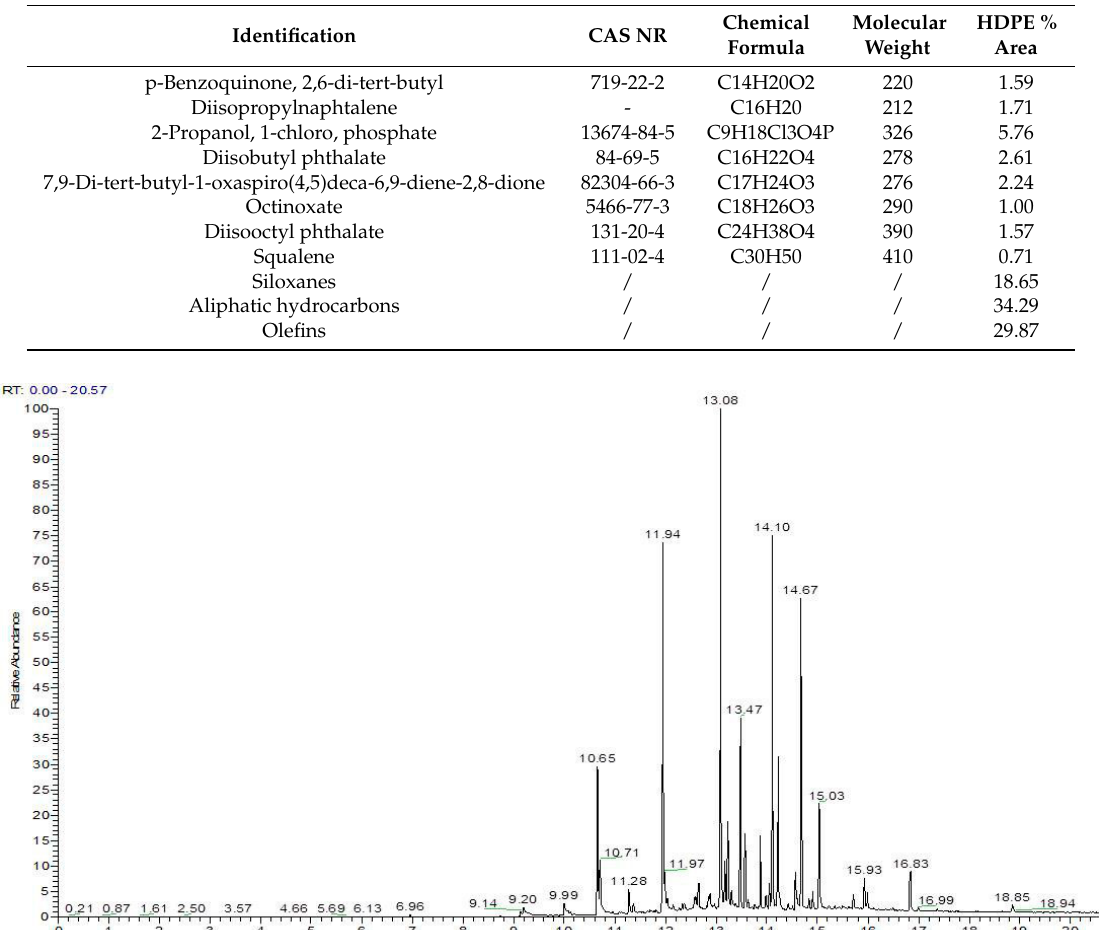
Table 7. Organic extractables profile of non-treated containers made of low-density polyethylene (LDPE)/high-density polyethylene (HDPE) mixture.